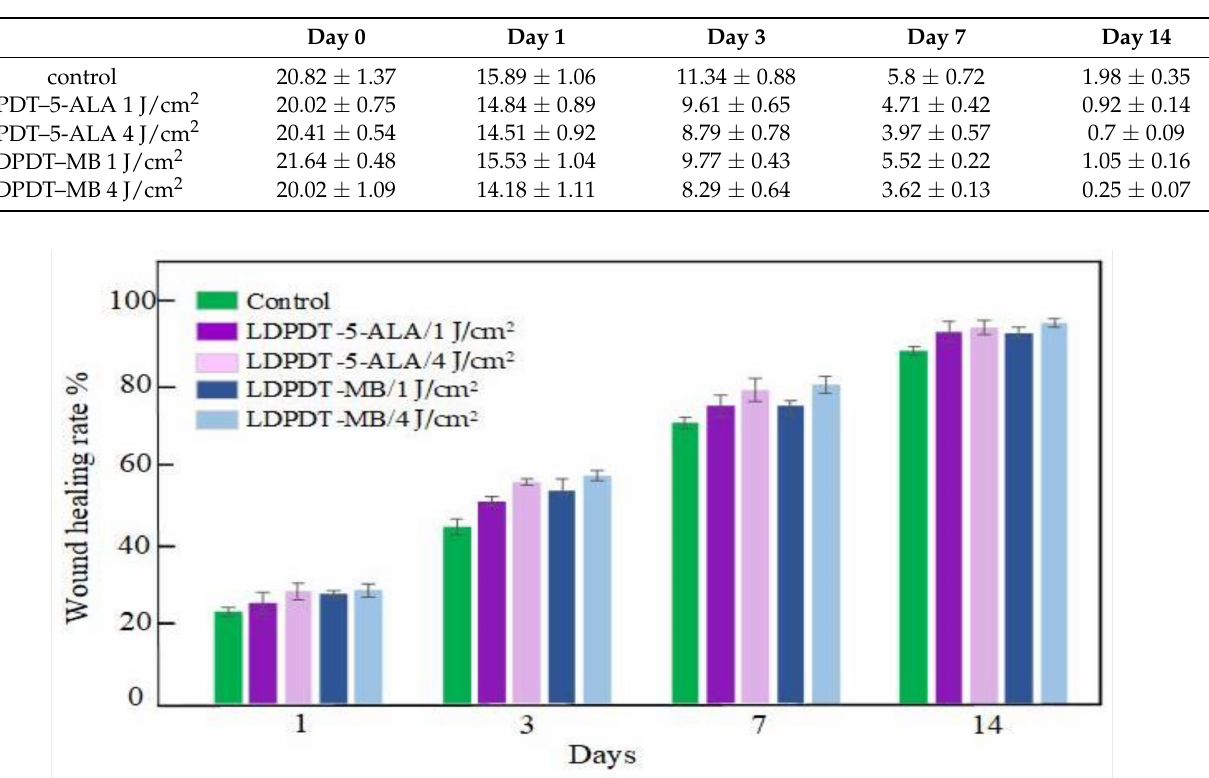
Table 1. The wound size in mm 2 during wound healing (mean ± standard deviation).